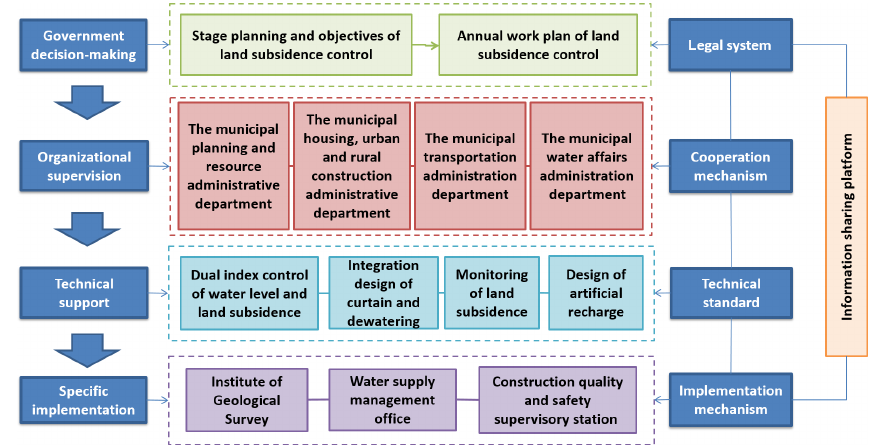
Figure 2. Management system framework of land subsidence control for deep foundation pit